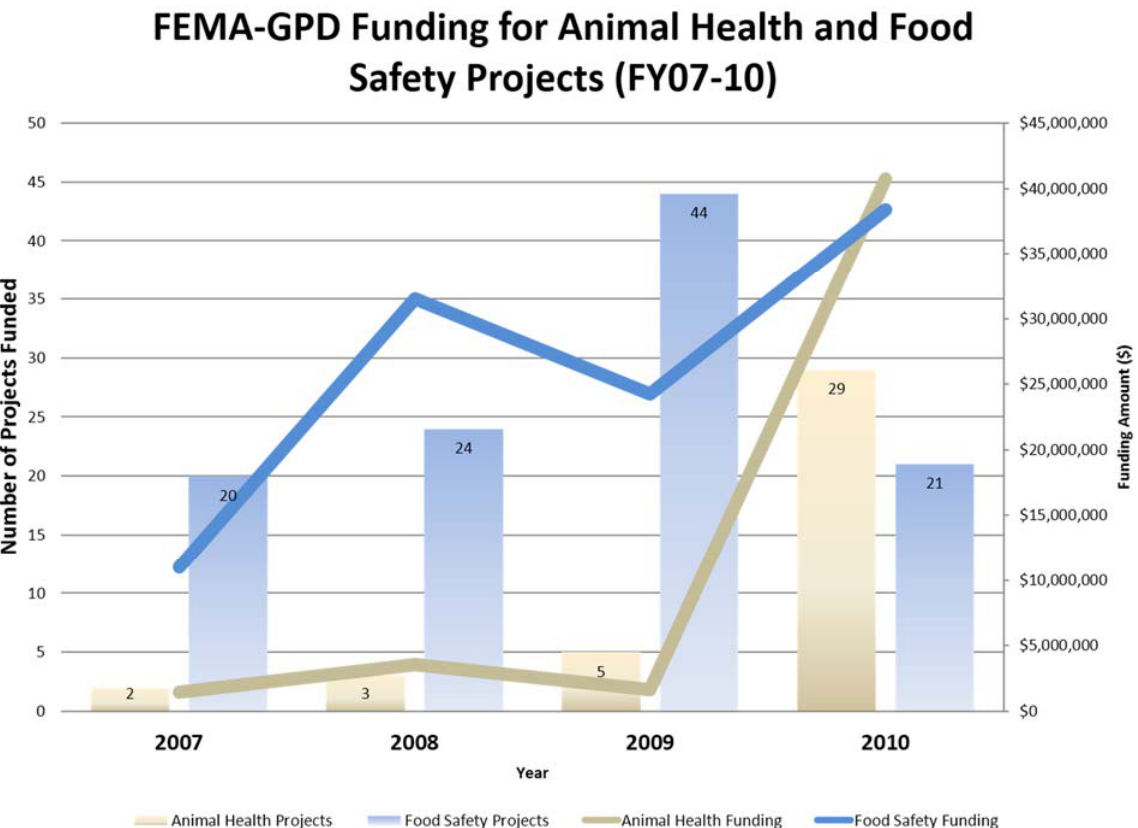
Figure 2. Summary of the total number of projects funded and funding obligated by